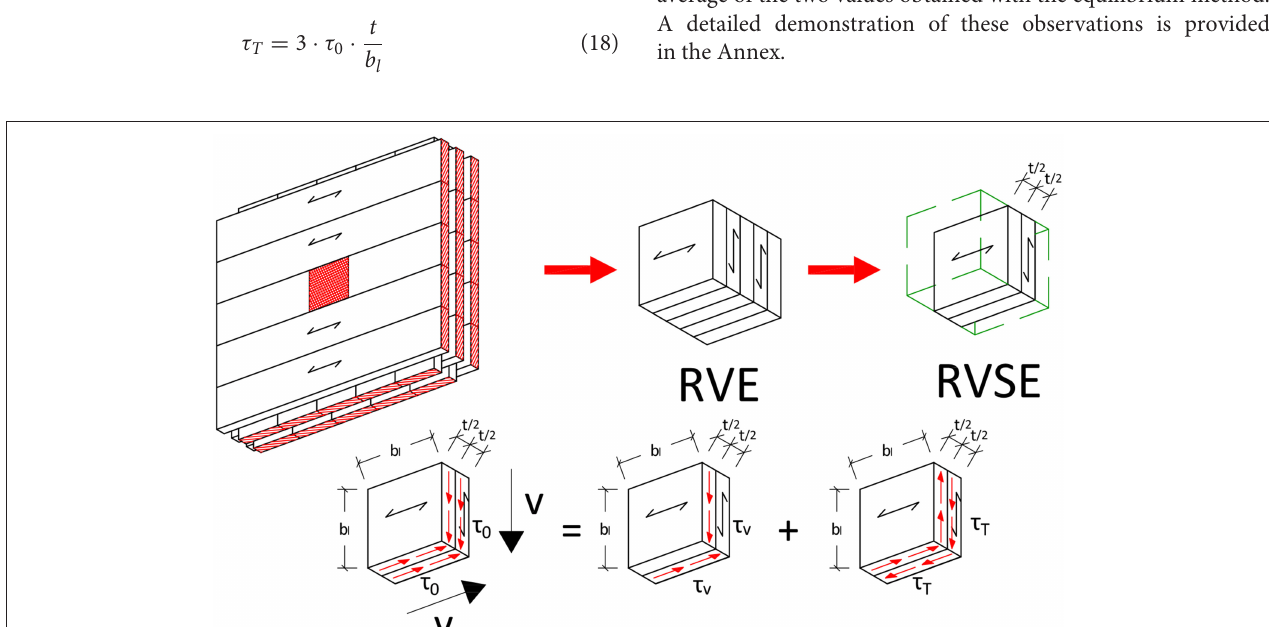
FIGURE 5 | Shear stresses for RVSE